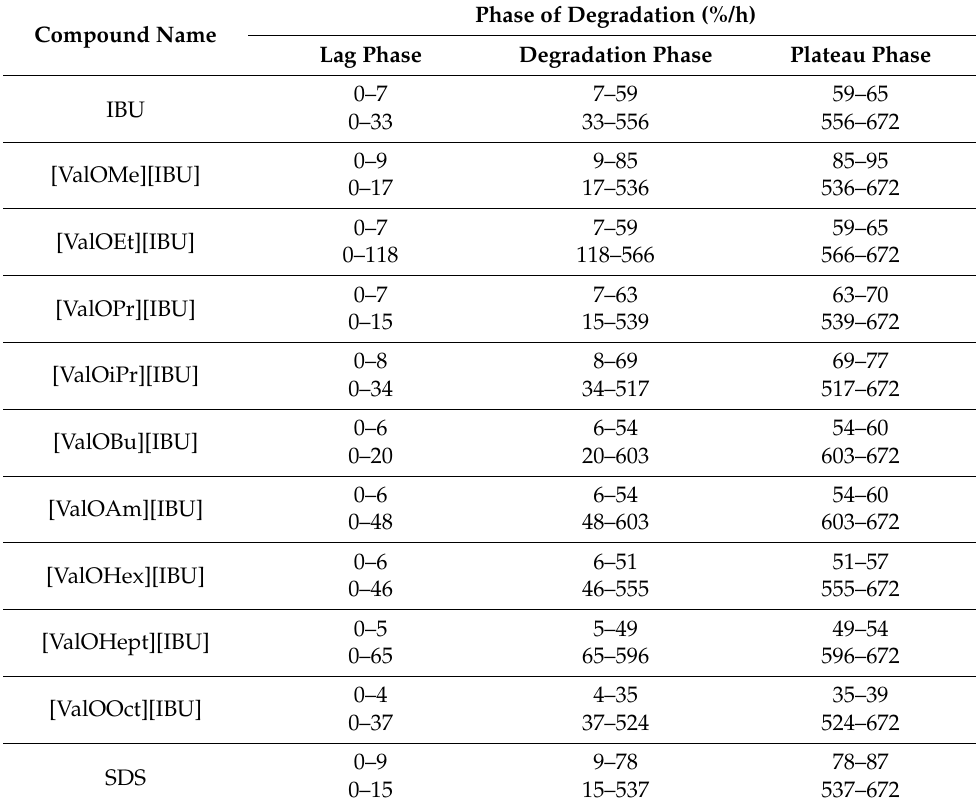
Table 2. Phase of degradation of ibuprofen and L-valine alkyl ester ibuprofenates by bacterial